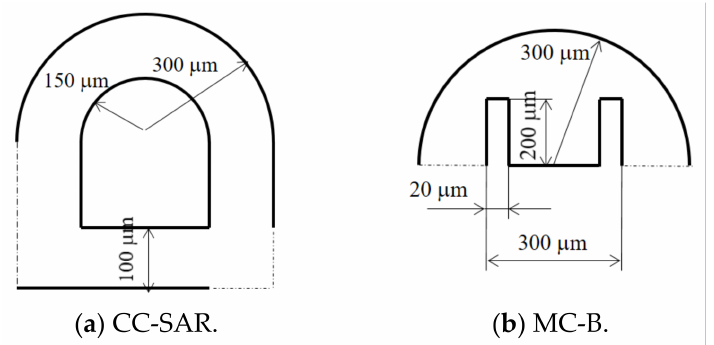
Figure 2. Two mixing units